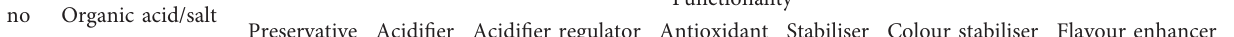
Table 3: Technological functionality of commonly used organic acids and their salts in food industry. E. no